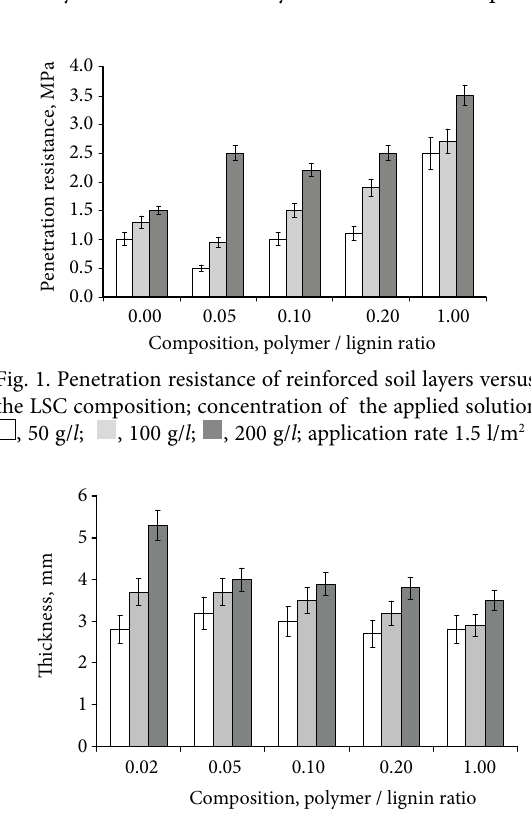
Fig. 2. Thickness of reinforced soil layers versus the LSC composition; concentration of the applied solutions: 50 g/ l